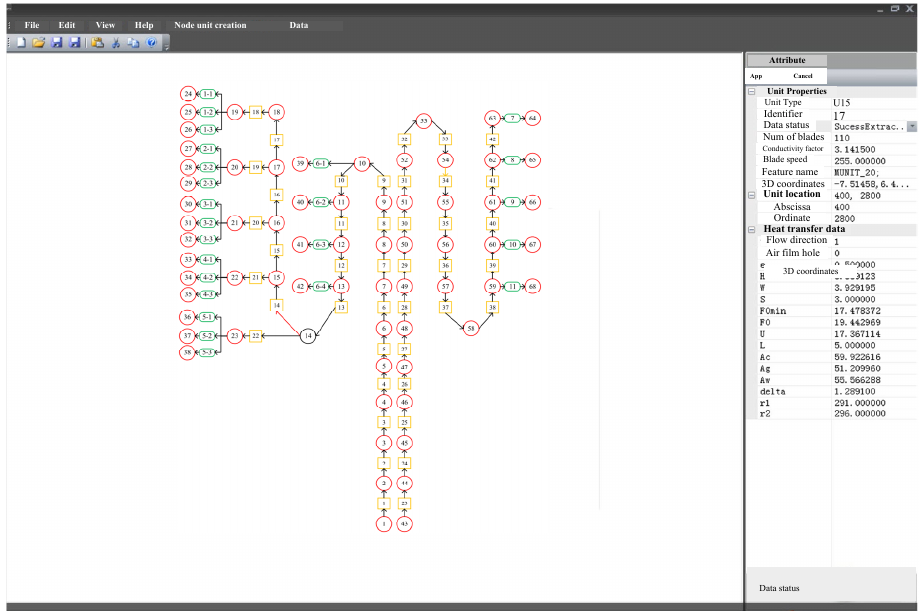
Figure 34. Blade model and division: ( a ) The blade 3D geometric model; and ( b ) the blade 3D geometric model after adaptive division.